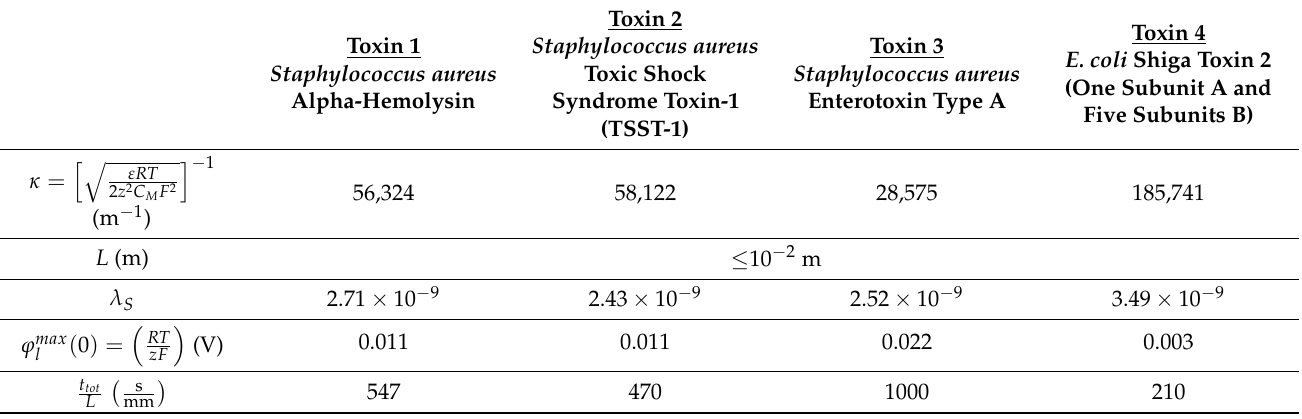
Table 4. Calculation of toxin movement time t tot maximum potential applied to one side of the duct for which the linear approximation holds, L : width of the